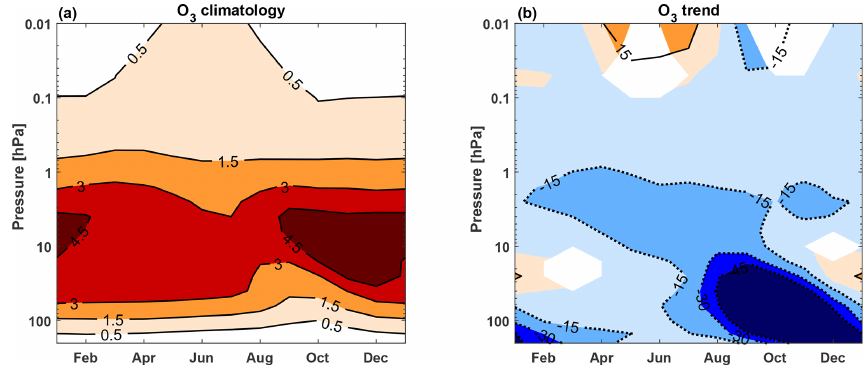
Figure 1. (a) Zonal mean ozone climatology in the Antarctic (70–90 ◦ S, 0.01–200hPa) during 1958–2008. Contour levels are 0.5, 1.5, 3 and 4.5 parts per million (ppm). (b) Zonal mean ozone trend in the Antarctic (70–90 ◦ S, 0.01–200hPa) during 1958–2008. Positive contour level (solid line) is 15%, and negative contour levels (dotted lines) are − 15%, − 30% and − 45%. Colour shading indicates areas significant at the 95% level, calculated with a Mann–Kendall test and a false detection rate. Figures were made using the reference simulation (see details in “Data and